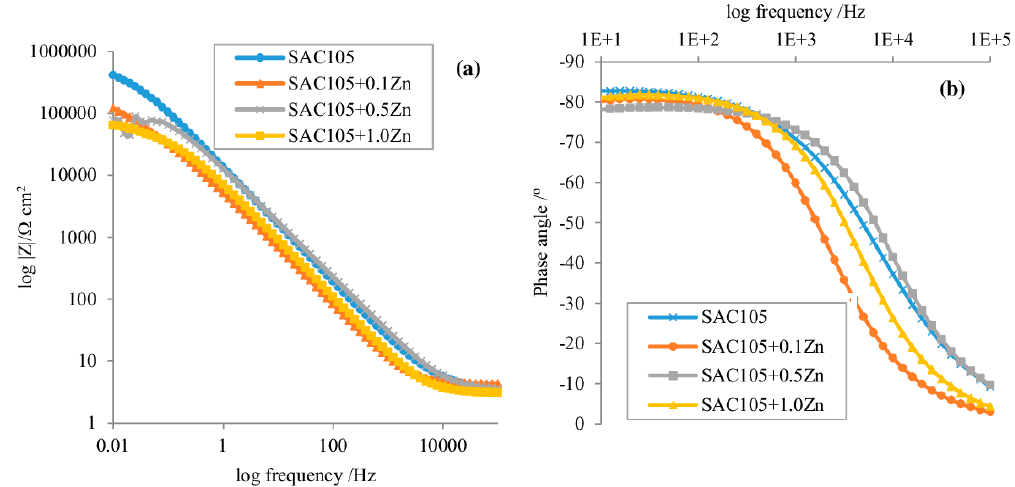
Figure 3. Bode plots: ( a ) Magnitude Bode plot; ( b ) Phase angle Bode plot for SAC105- X Zn ( X = 0, 0.1, 0.5, 1 wt %) solder alloys in 3.5 wt % NaCl solution [55].